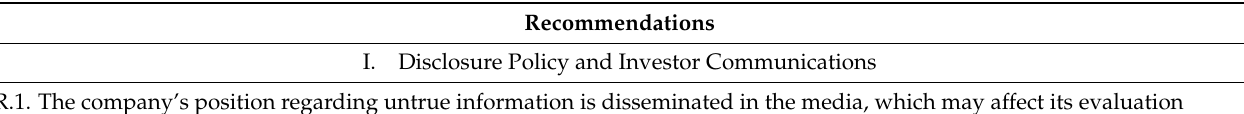
Table A1. Best Practices for WSE-LCs 2016—Recommendations’ structure